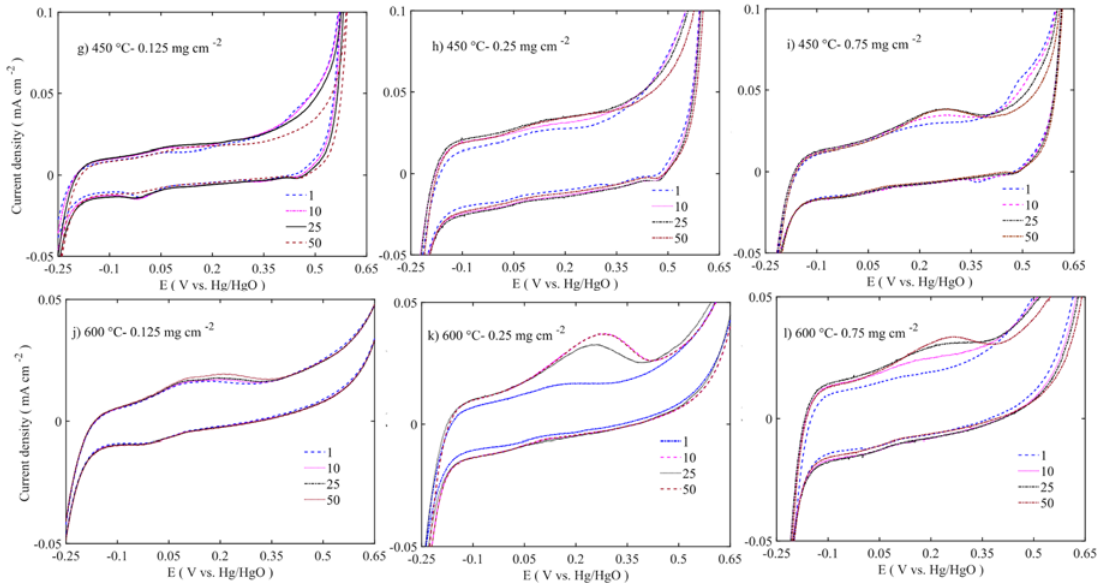
Figure 12. Enlarged view of the electrochemical stability curve of the samples calcined at 250 °C ( g – i ) and 250 °C; ( j – l ) in different loadings of 0.125–0.75 mg cm − 2 .